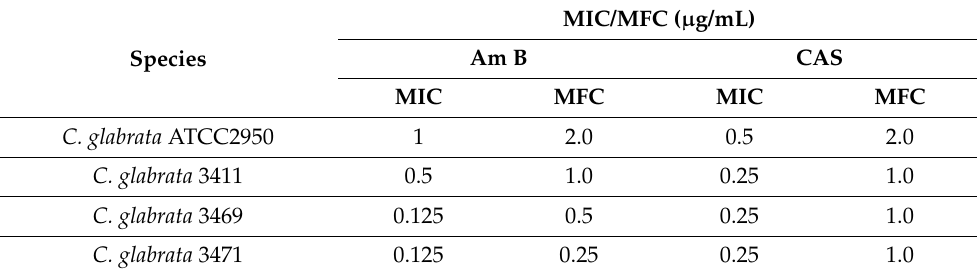
Table 1. Antifungal susceptibility profile of C. glabrata